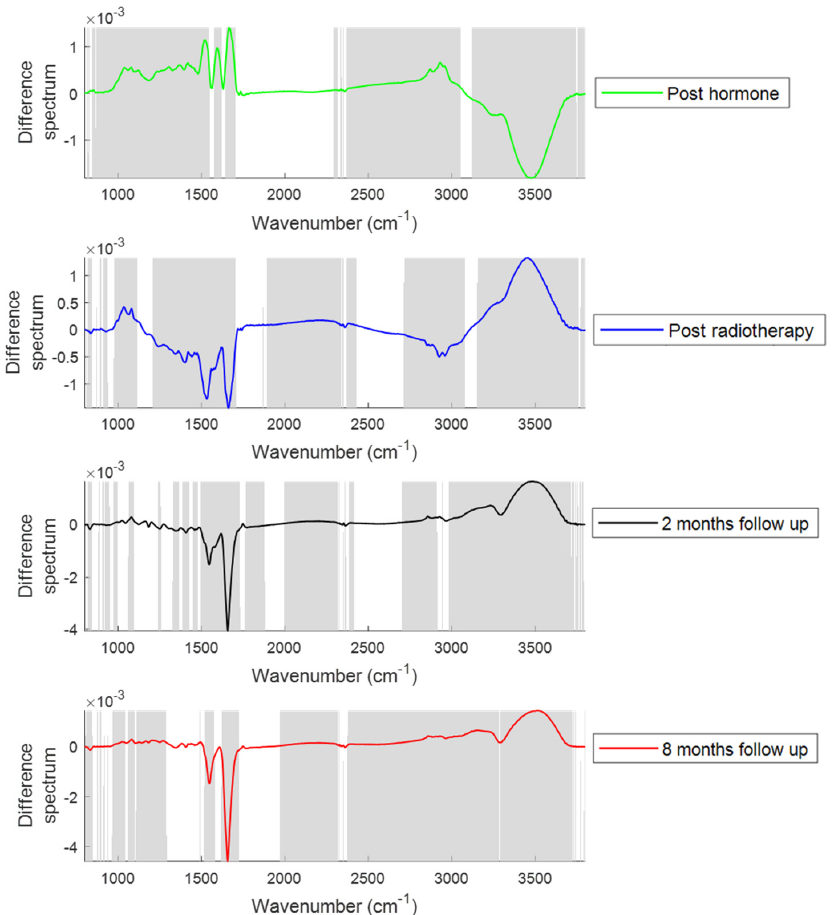
Figure 2. Difference spectra of plasma from patients post hormone treatment, post radiotherapy, at two months follow up and at eight months follow up. Difference spectra were computed by subtracting the mean spectra of plasma from the patients at different treatment time points from their mean spectra at baseline. The shaded regions depict the spectral regions which are significantly different between each sample set using a two-tailed t -test with p < 0.001.